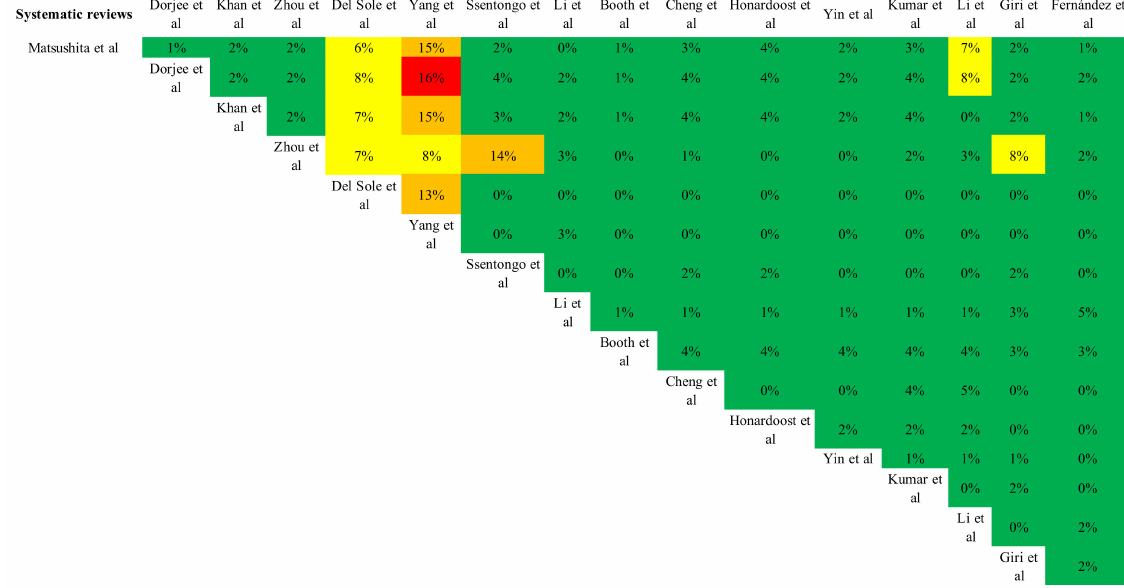
Figure 2. Estimation of the overlap across studies included in the umbrella systematic review quantified by using the corrected covered area. Green: light degree of overlapping (0–5%); yellow: moderate degree of overlapping (6–10%), orange: high degree of overlapping (11–15%); and red: very high degree of overlapping (>15%).